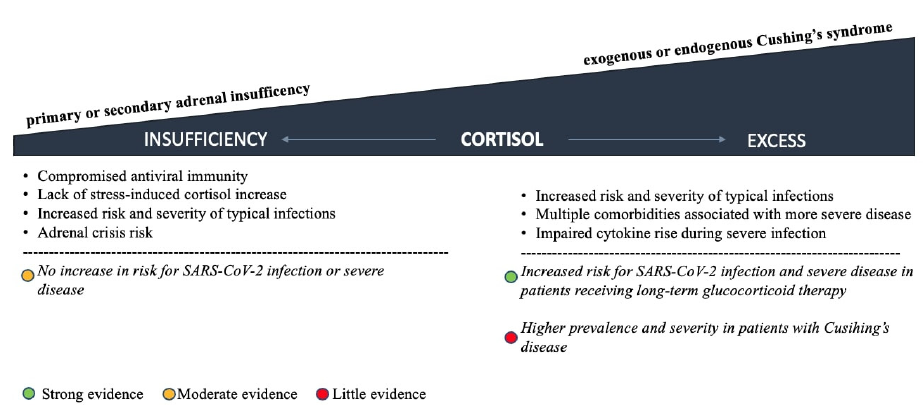
Figure 3. Glucocorticoid disorders and their impact on risk of infection and disease